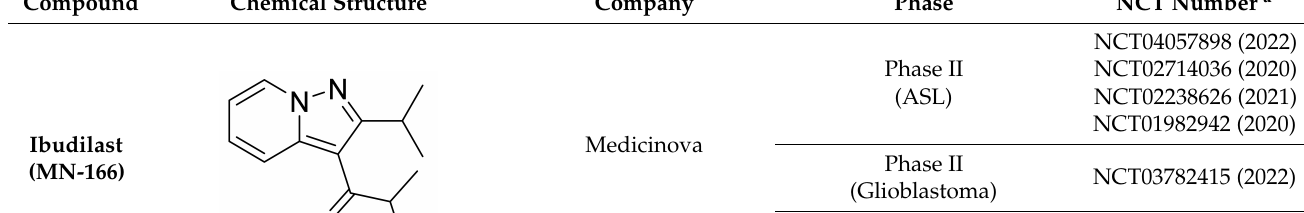
Table 4. PDE4 inhibitors under development for the treatment of different neurological disorders. Compound Chemical Structure Company